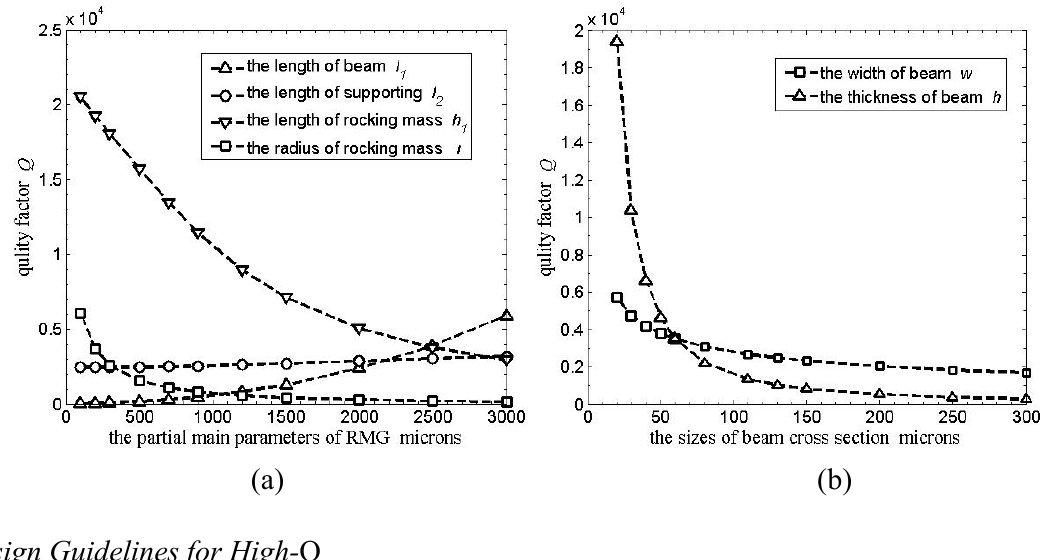
parameters. (b) Q dependent on the cross section sizes of the